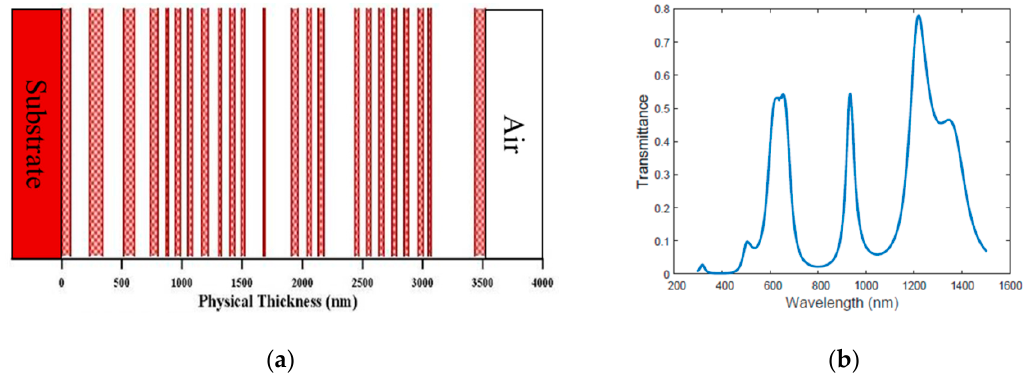
Figure 2. ( a )Thin-film structure of an example MOE; ( b ) corresponding transmission spectrum of the MOE.